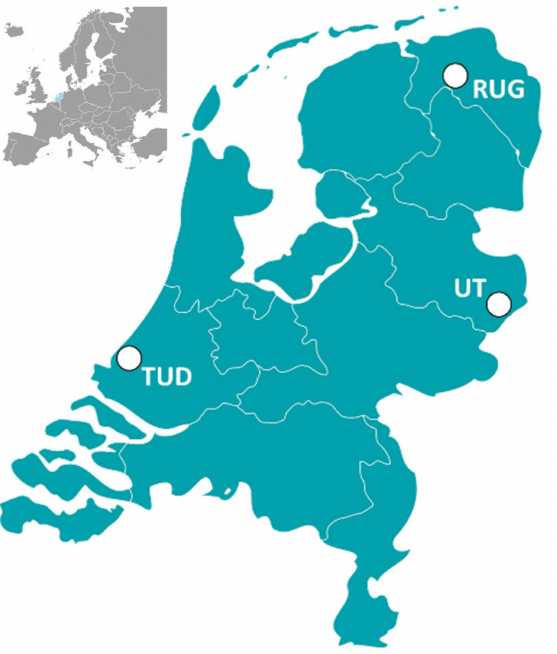
Figure 1. Locations of the three studied university campuses in The